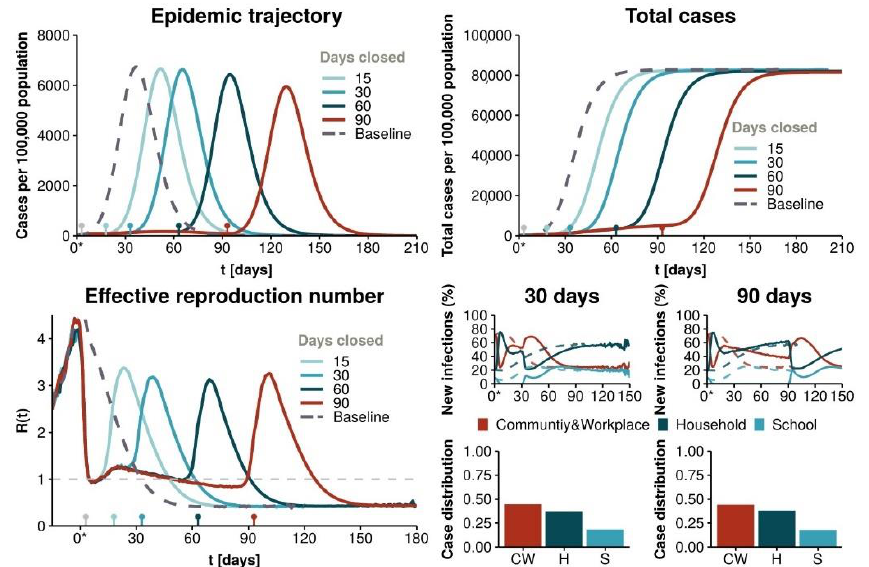
Figure 1. Mathematical model predictions for a strategy of total confinement [65]. Reproduced from [65].